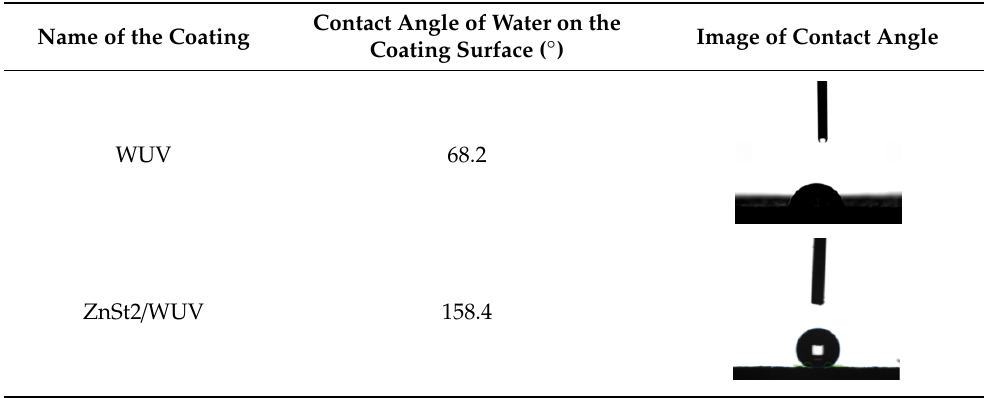
Table 1. Image of contact angle (A: WUV; B: ZnSt2/WUV)